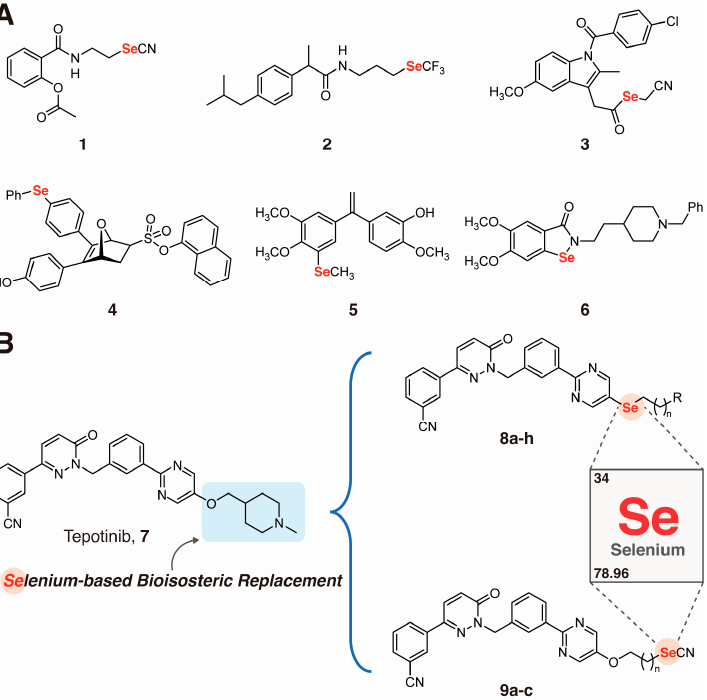
Figure 1. ( A ) Structures of Se–aspirin 1 , Se–flurbiprofen 2 , Se–indomethacin 3 , Se–OBHS (oxabicycloheptene sulfonate) 4 , Se– iso CA4 5 and Se–donepezil 6 . ( B ) Design of multifunctional c- Met inhibitors 8a – h and 9a – c containing a Se